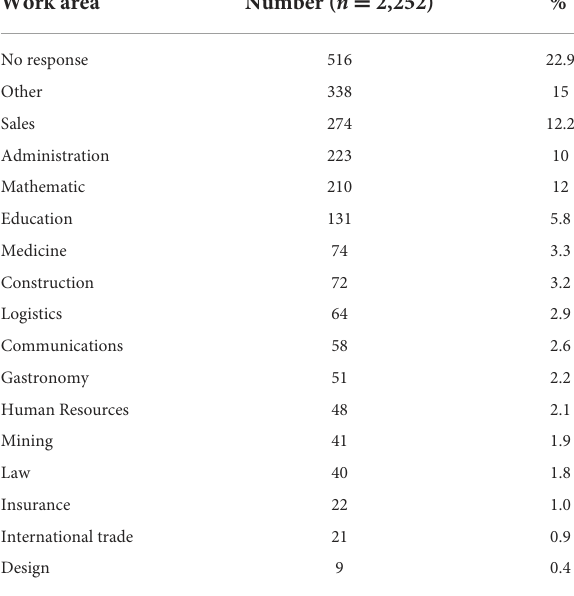
TABLE 2 Respondents’ work